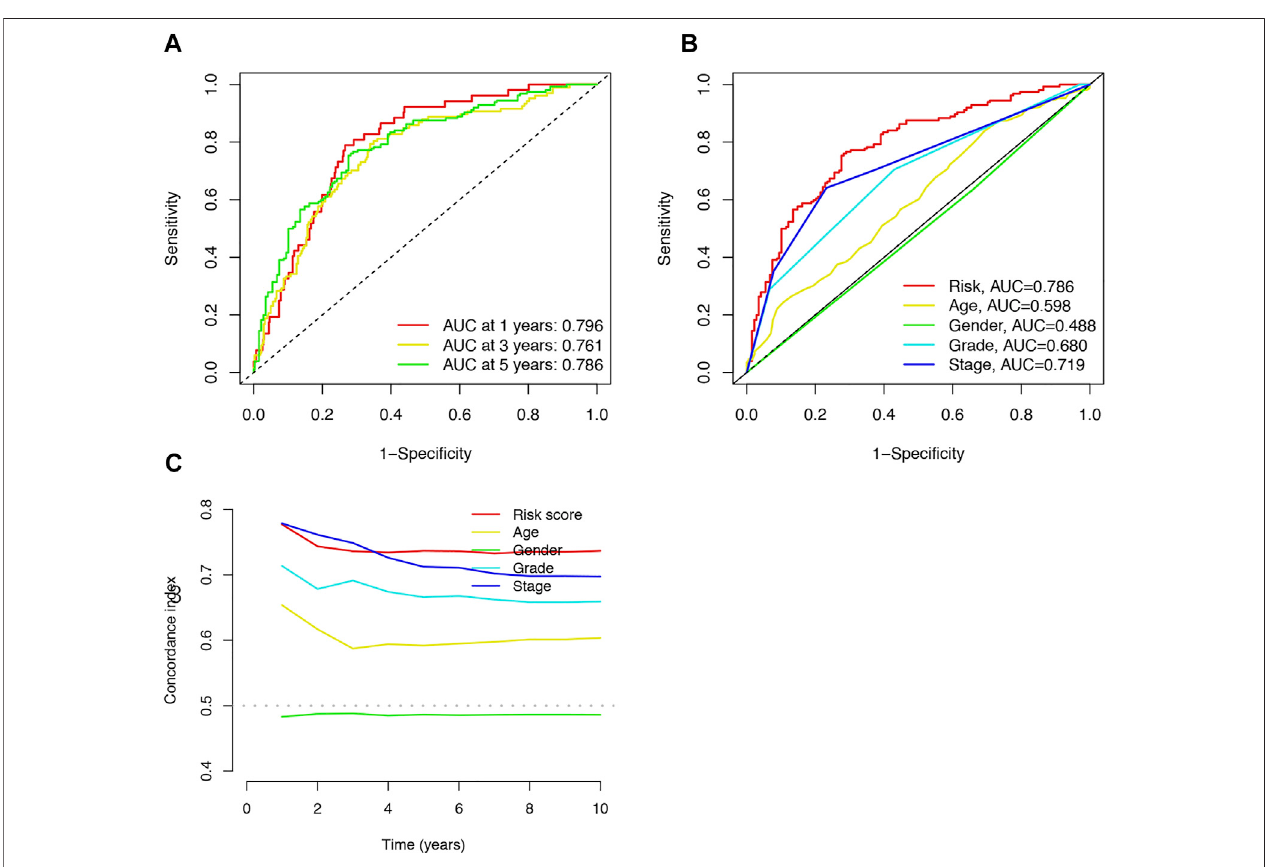
FIGURE 4 | Accuracy of the risk characteristic based on a whole-group prediction of 1-, 3-, and 5-years receiver operating characteristic curves (A) . Predictive accuracy of the risk model compared with clinicopathologic characteristics such as age, sex, and stage (B) . C-index curve of the risk model (C) .